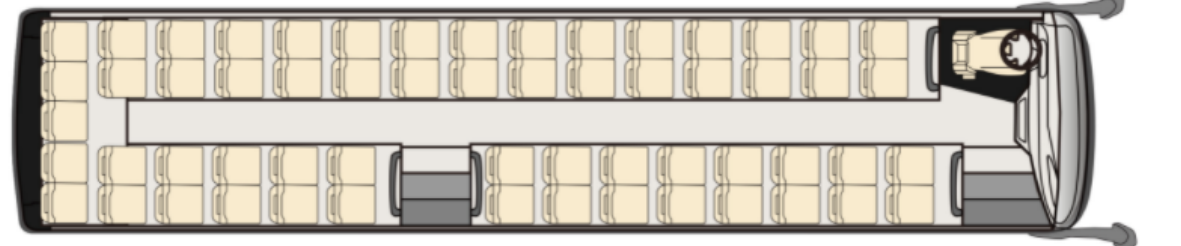
Figure 9. Considered bus Figure 9 . Considered bus layout. Table 2. Electric bus technical details.